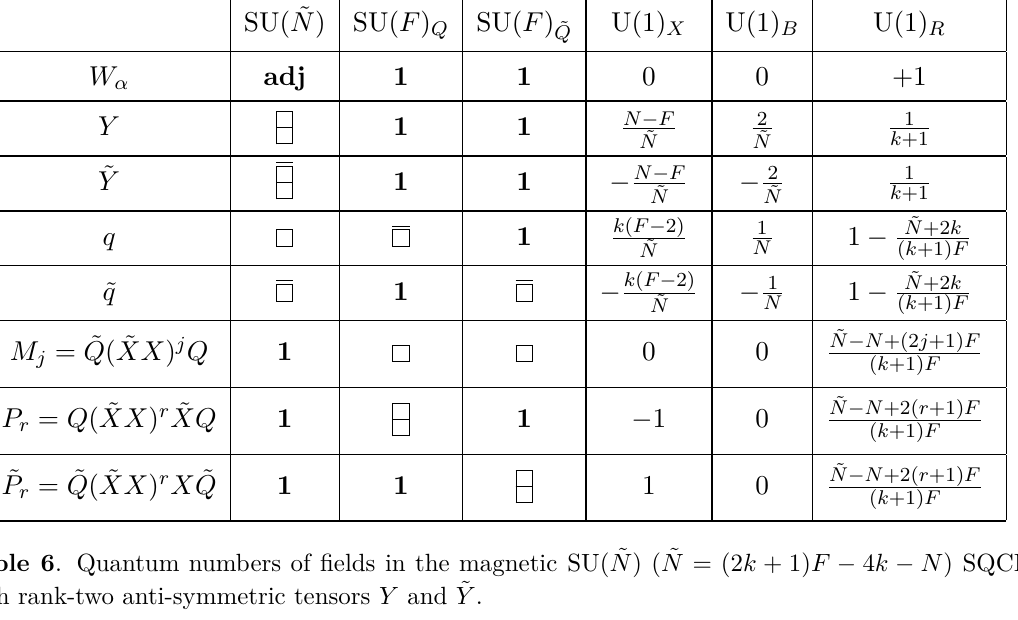
Table 6 . Quantum numbers of fields in the magnetic SU( with rank-two anti-symmetric tensors Y and ˜ Y